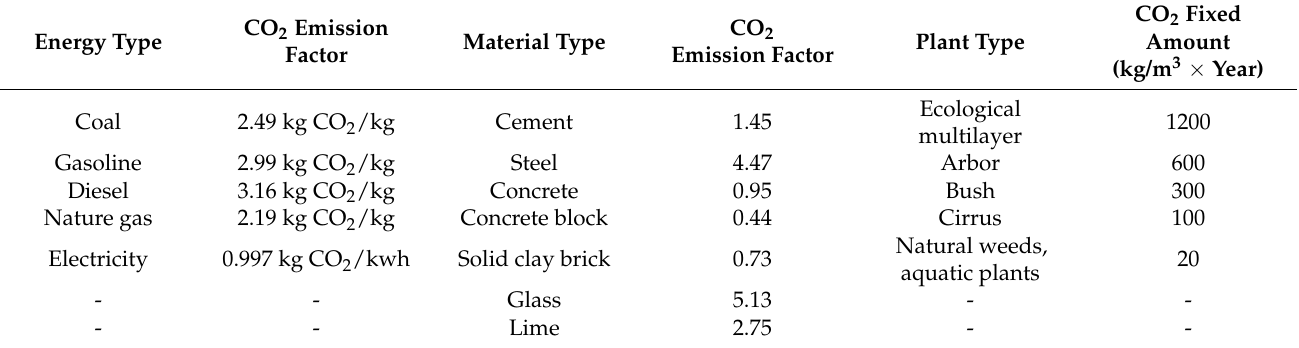
Table 3. CO 2 emission